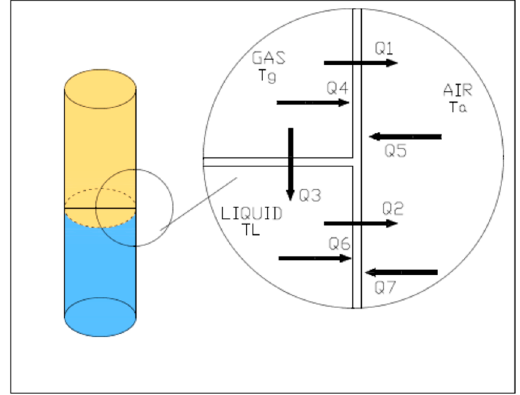
Figure 3. Scheme of the energy budget for the storage system.